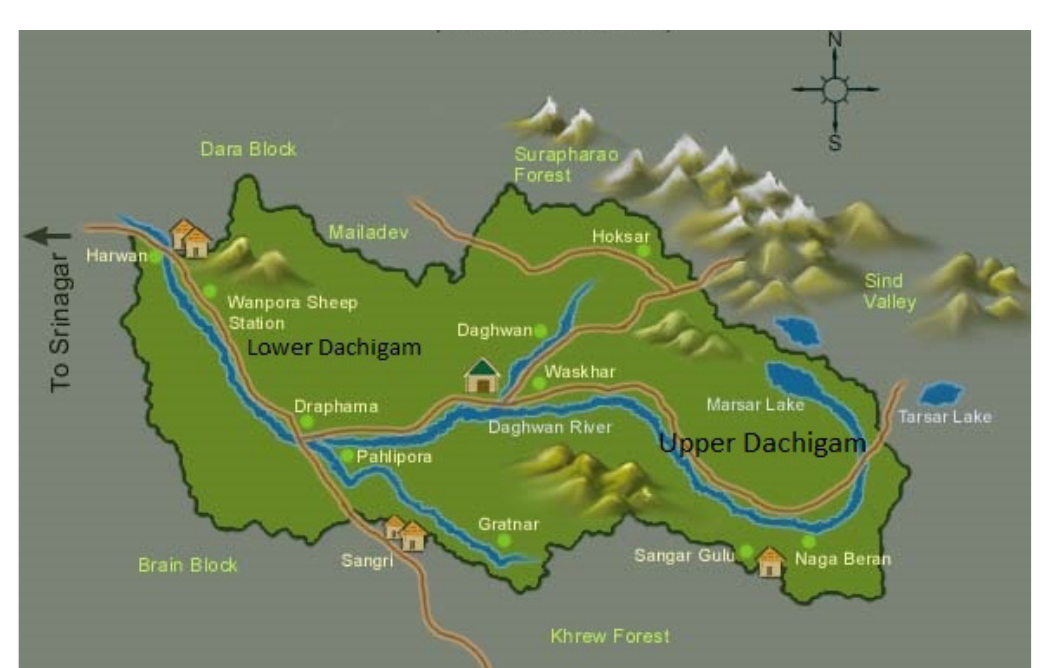
Figure 1. Map of Dachigam National